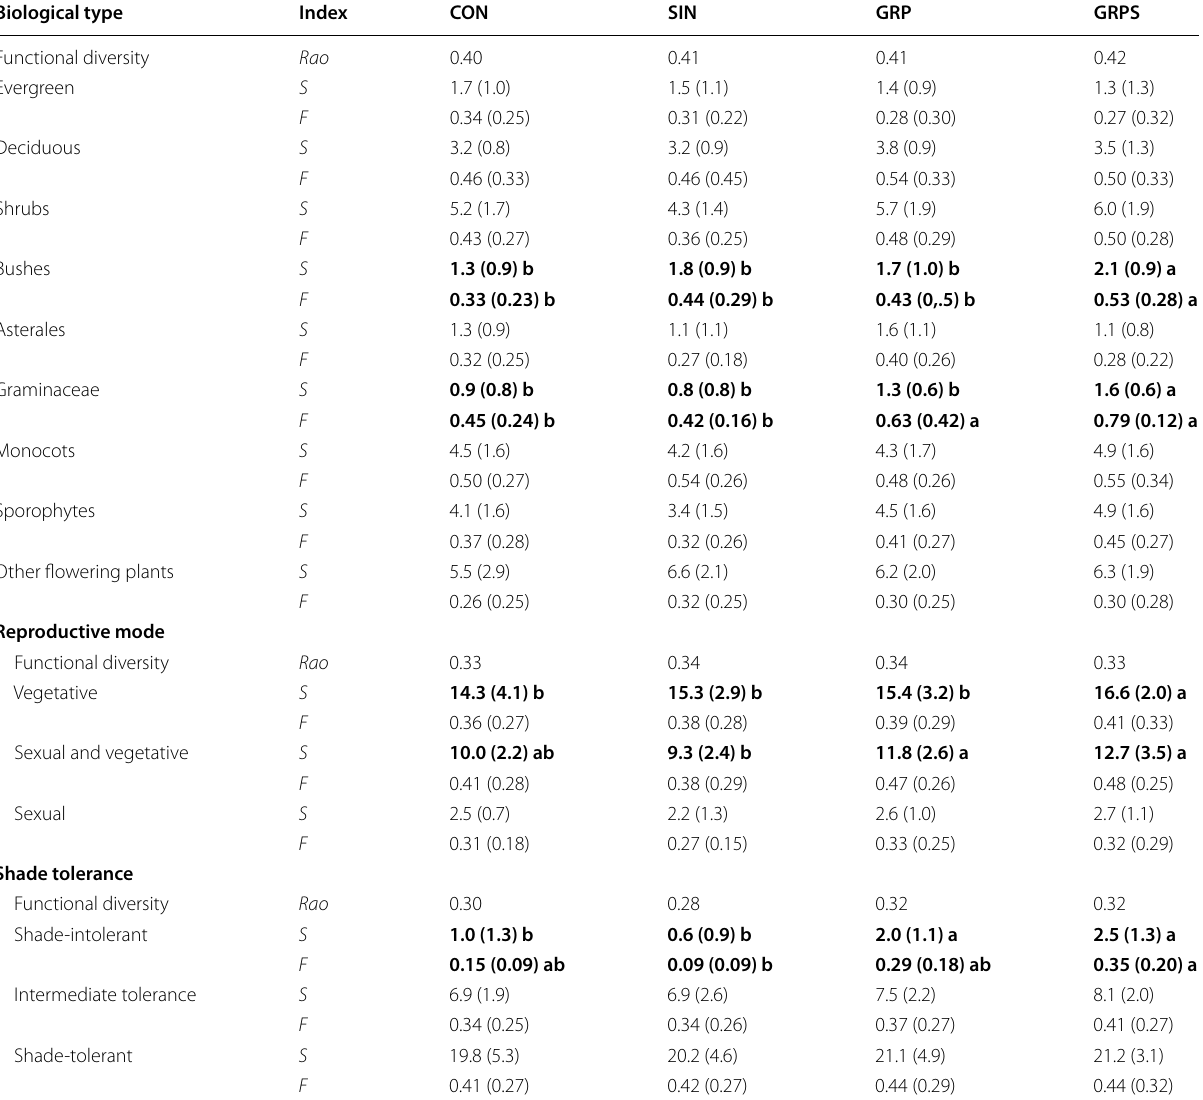
traits as a function of regeneration